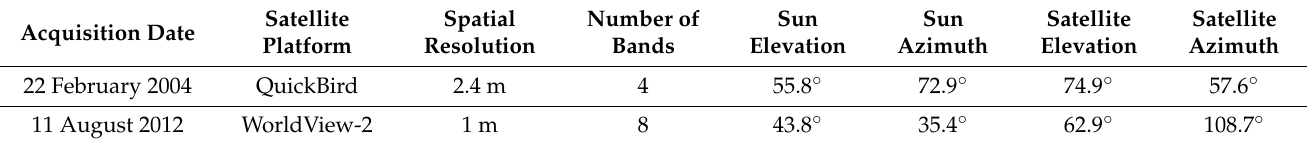
Table 1. Specifications of the VHR images.